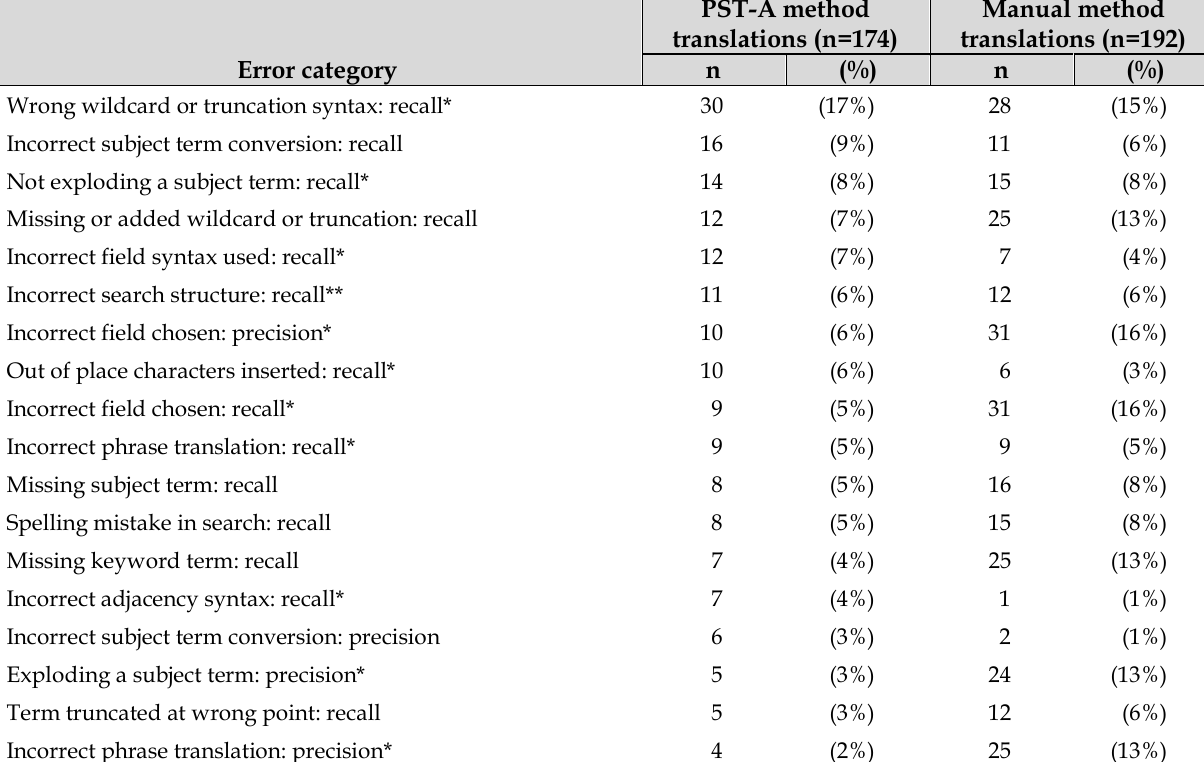
Table 3 Number and percent of unique errors in search string